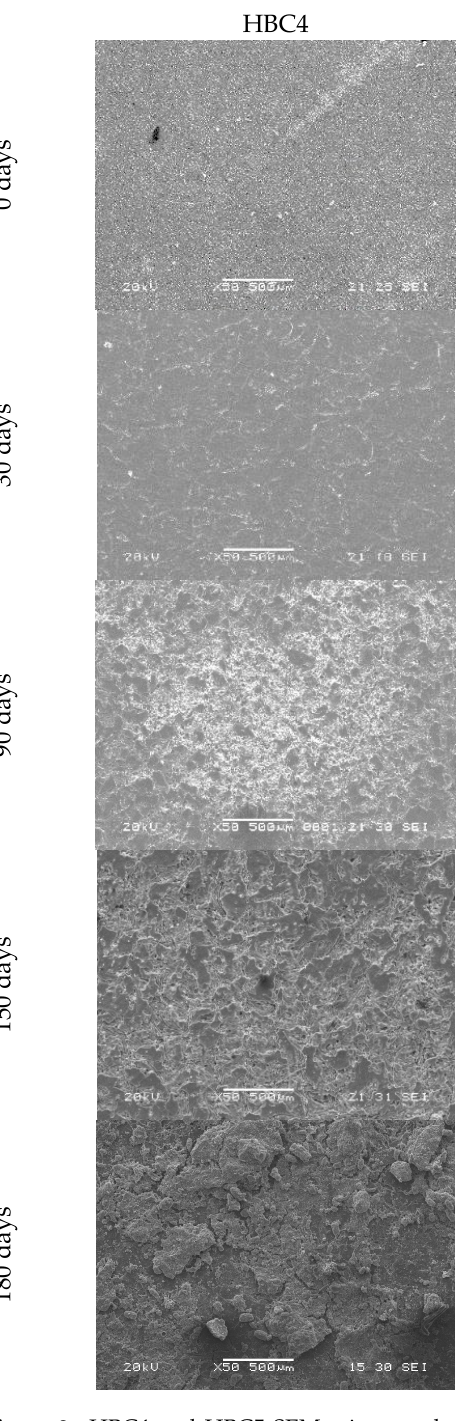
Figure 2. HBC4 and HBC5 SEM micrographs at different composting days (0, 30, 90, 150, and 180 days).